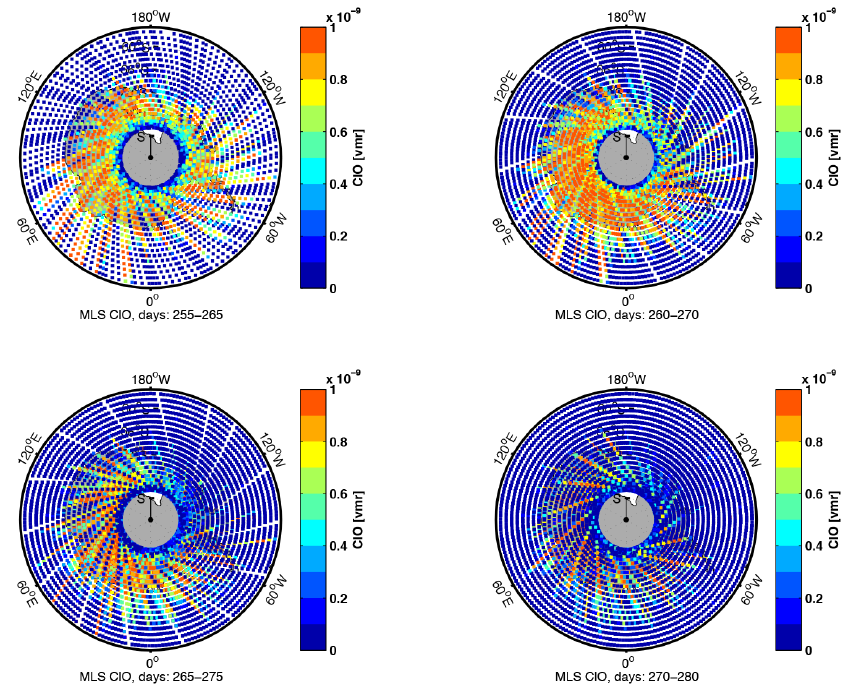
Figure 7. Microwave Limb Sounder ClO data retrieved on the 68.13hPa level over the 10 day periods used for the four ozone loss calculations in Figs. 3 and 4.